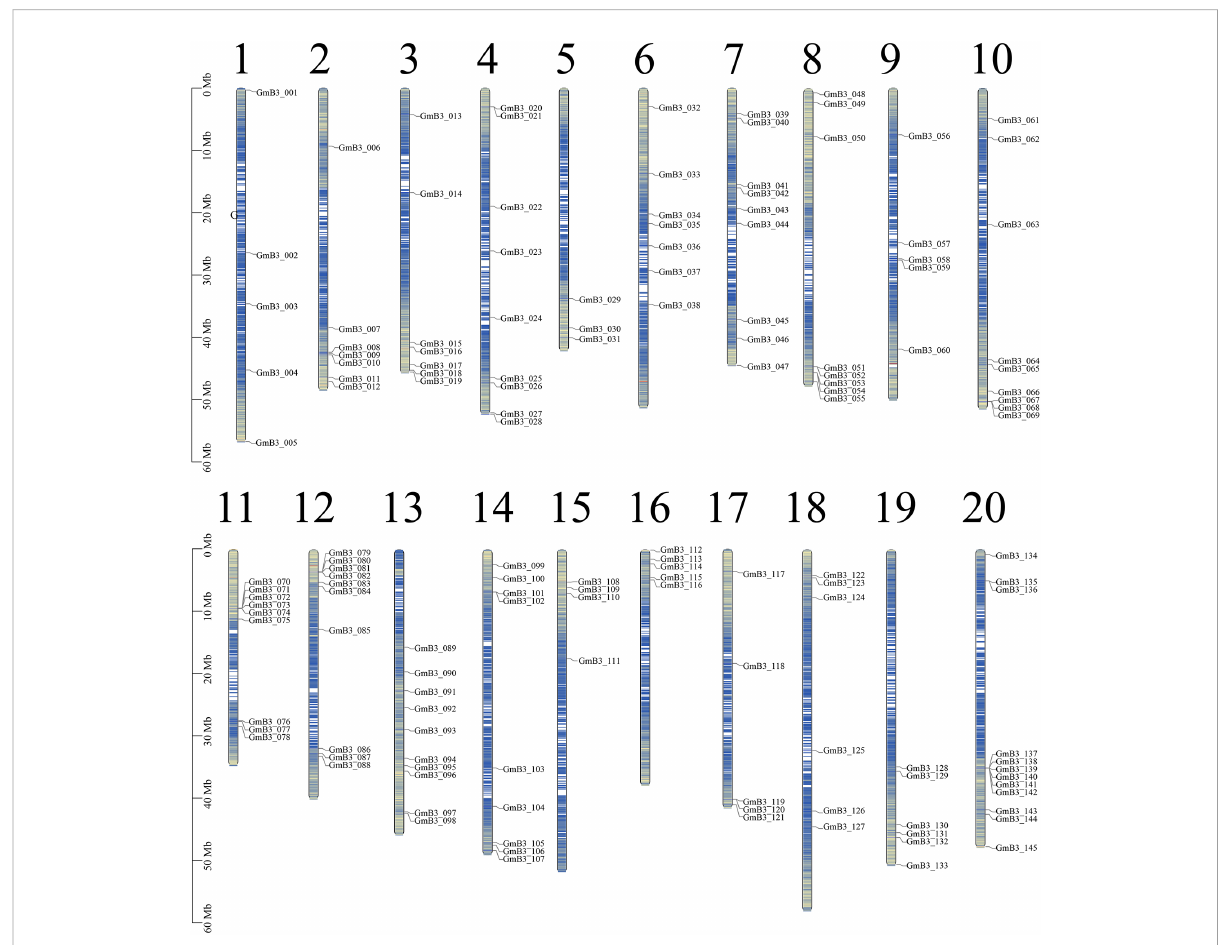
FIGURE 4 Chromosomal distribution of the 145 GmB3 genes identi fi ed in the present study. The chromosome number was indicated above the